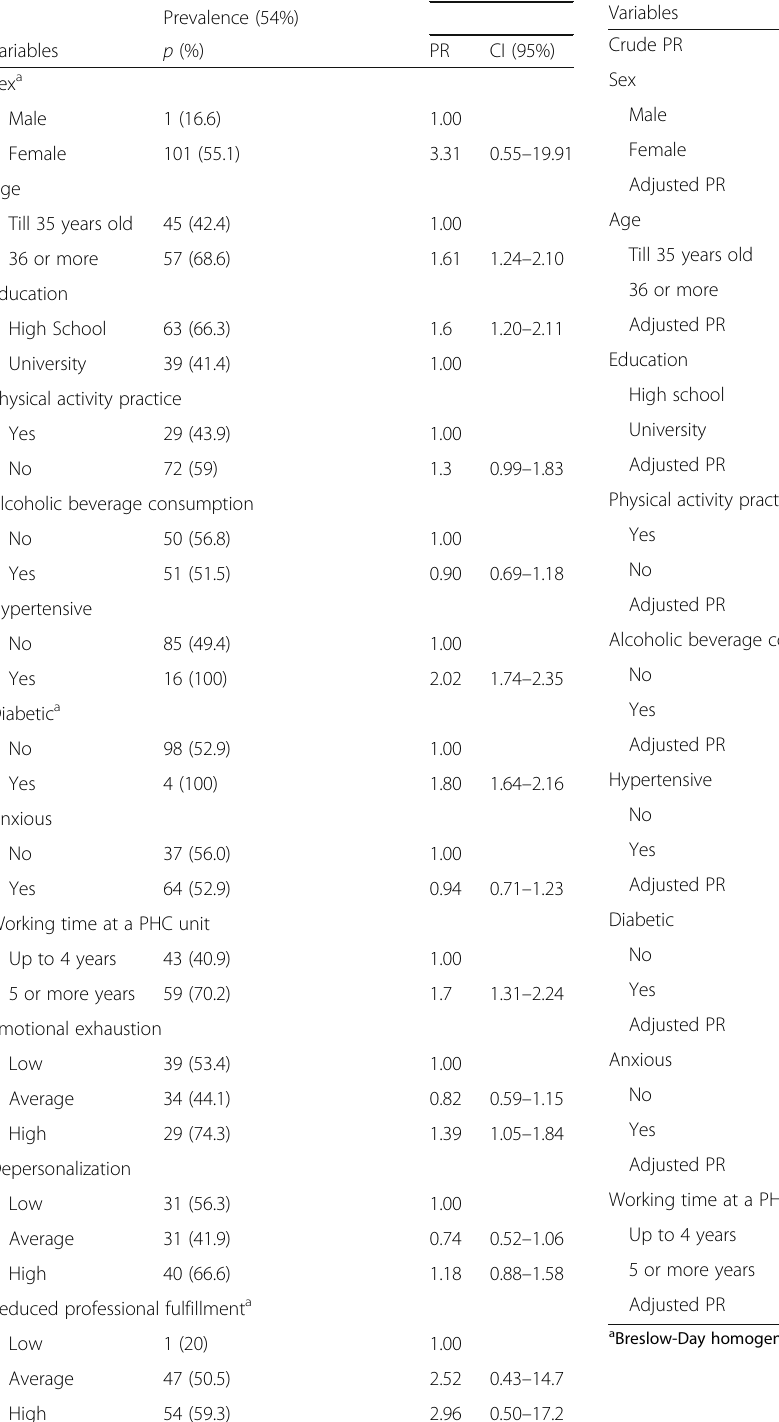
Table 2 Sociodemographic and occupational characteristics, lifestyle, and morbidity related to abdominal adiposity ( N = 189),